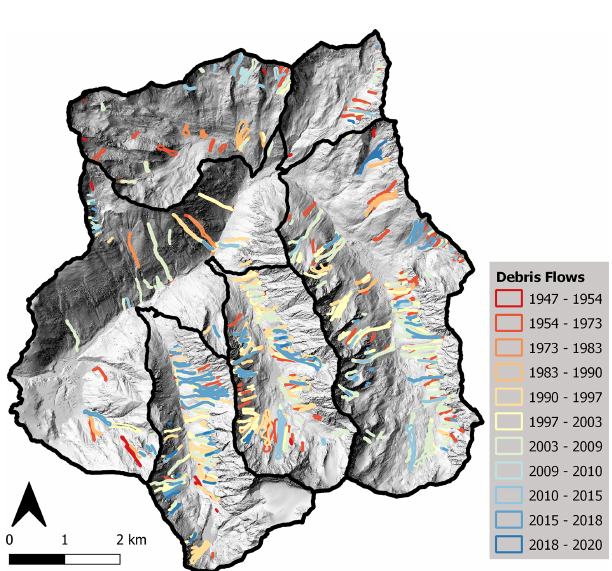
Figure 4. Results of the debris flow mapping in the entire study area. More recent debris flows overlay older ones in some places.